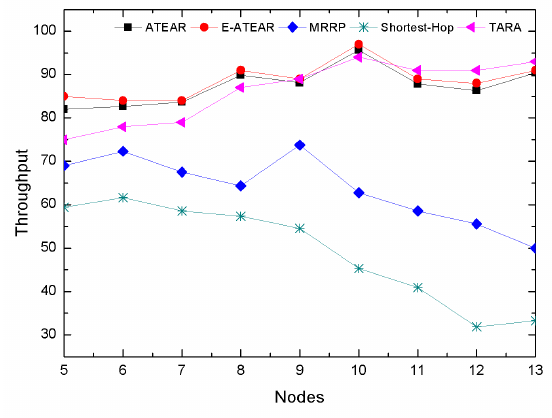
Figure 11. Throughput with different node